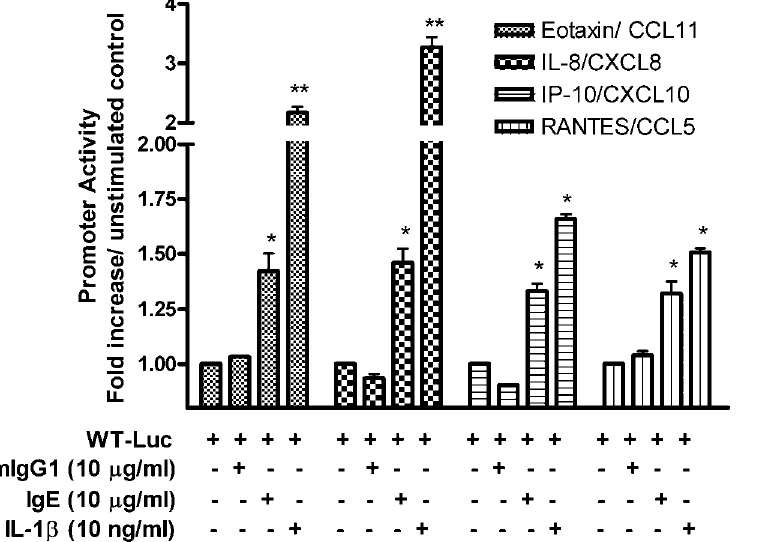
Figure 4. IgE-sensitization induces the chemokines promoter activity in human B/TSM cells. Cultured human B/TSM cells were transiently transfected with luciferase reporter constructs driven by wild-type promoters for human eotaxin-1/CCL11, IL-8/CXCL8, IP-10/CXCL10, and RANTES/ CCL5; stimulated with mIgG1-MOPC21, IgE, or IL-1 b ; and respective chemokine promoter activity was measured as mentioned in Materials and Methods . Data were normalized according to the Renilla luciferase activity, and presented as fold-increase over unstimulated control. Data represents the mean 6 SD of three separate experiments. Mann-Whitney U test was performed to analyze the differences between the samples. * P , 0.05, ** P , 0.01 compared to unstimulated